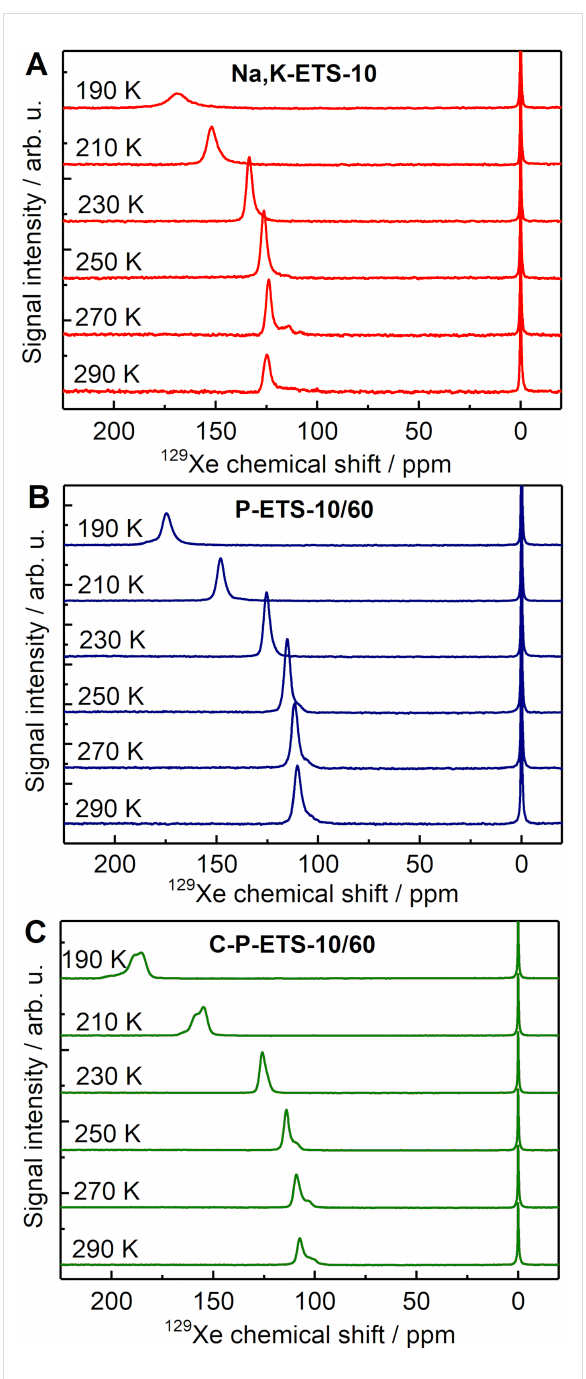
Figure 15: Variable temperature HP 129 Xe NMR spectra acquired on Na,K-ETS-10 (A, red), P-ETS-10/60 (B, blue) and C-P-ETS-10/60 (C, green). The chemical shift scale is referenced to the signal of free Xe gas measured in an empty tube at 290 K.